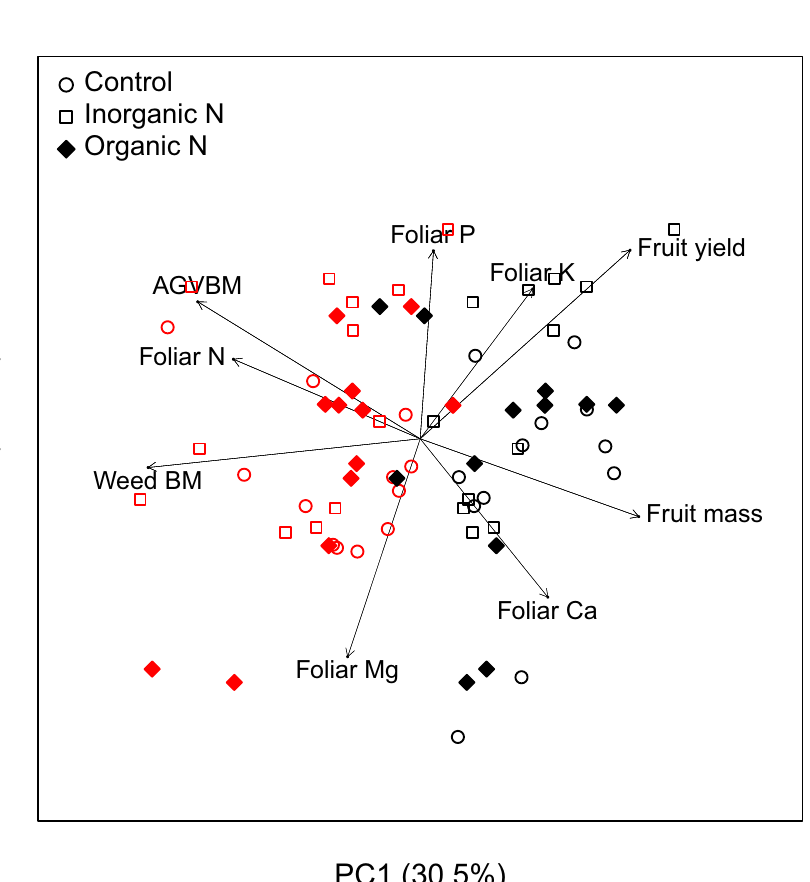
Fig 6. Principal component analysis of C . peregrina and D . spicata plots. C . peregrina (red symbols) and D . spicata (black symbols) are presented with the variables of blueberry aboveground vegetative biomass (AGVBM; t ha -1 ), fruit yield (t ha -1 ), individual fruit mass (mg), weed aboveground biomass (Weed BM; t ha -1 ), and foliar concentrations of N, P, K, Ca, and Mg (mg g -1 ).